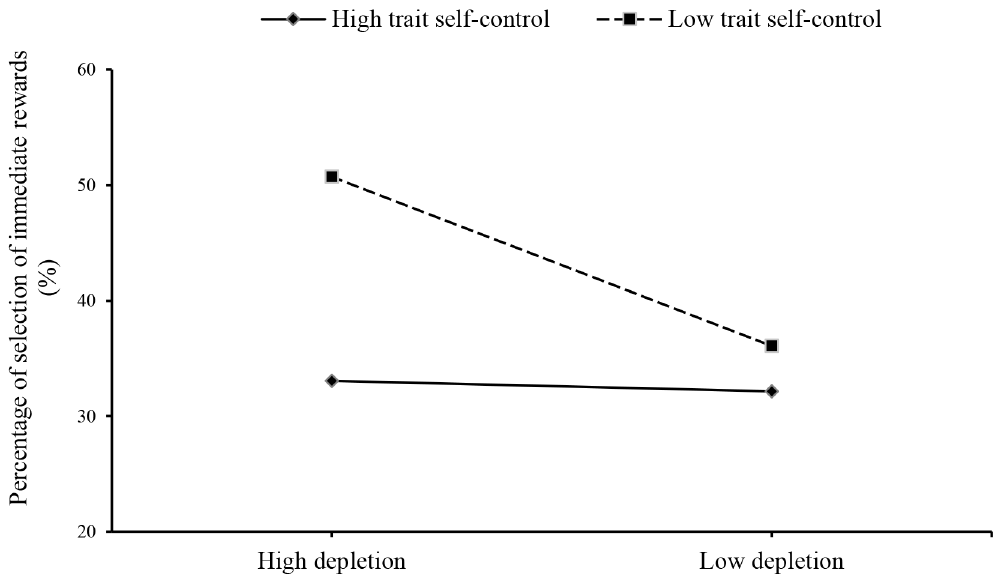
Fig 4. Percentage of selection of immediate rewards (%).